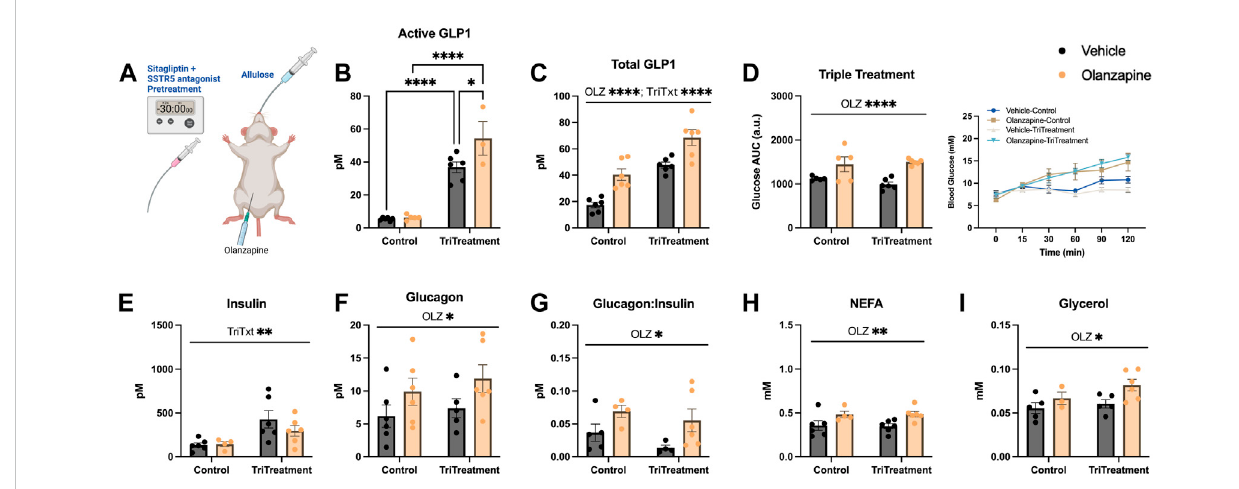
FIGURE 3 Tripletreatmentwithallulose,sitagliptin,andsstr5antagonistdoesnotprotectagainstolanzapine-inducedchangesinglucoseorlipidhomeostasis. Mice were treated with a mixed oral gavage of sitagliptin (10 mg/kg) and SSTR5 antagonist (15 mg/kg) 30 min prior to an oral gavage of allulose (1 g/kg) and an IP injection of olanzapine (5 mg/kg) (A) ( n = 4 – 6 mice/group). (B, C) Active and total GLP1 were measured from serum following 120 min from injection. (D) Blood glucose was measured from the distal tail blood and area under the curve (AUC) calculated. In serum collected from cardiac blood, insulin (E) , glucagon (F) , the ratio of glucagon:insulin (G) , Non-Esteri fi ed Fatty Acids (H) , and glycerol (I) were measured. Blood glucose AUC and serum hormones/metabolites were analyzed by two-way ANOVA. Lines over graphs indicate a main effect of the described parameter while bars connectedbylinesindicateasigni fi cantdifferencebetweenindicatedgroups.* p < 0.05,** p < 0.01,*** p < 0.001,**** p < 0.0001.Alldataarepresentedas mean ±